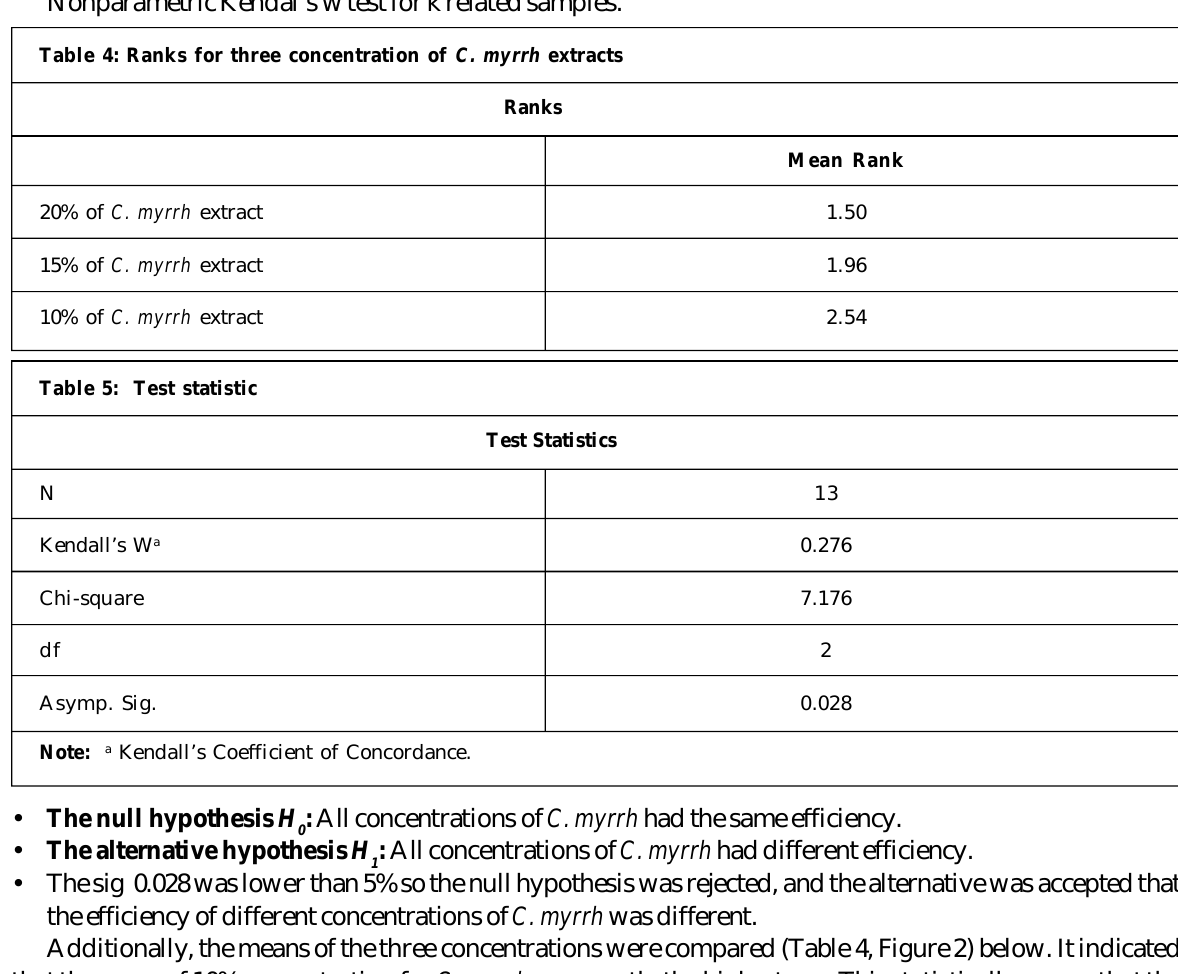
Table 4: Ranks for three concentration of C. myrrh extracts